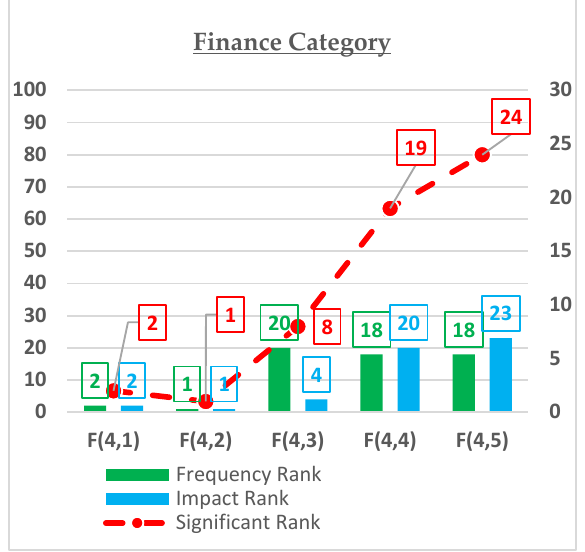
Figure 10. Significant risks in the finance category.